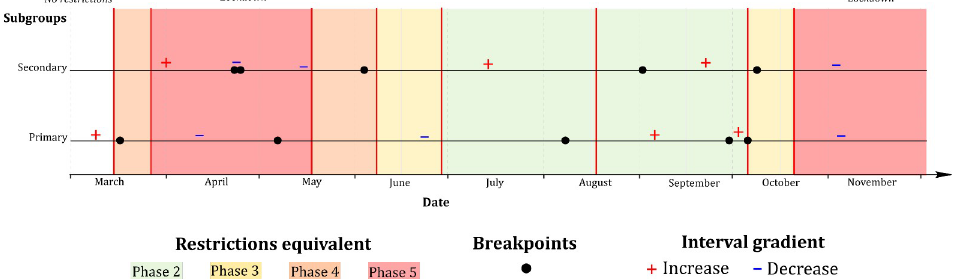
Fig 3. Grid synthesis of primary and secondary time-series breakpoint models (psi = 5) in the Republic of Ireland (cases/day), February 29 th to November 30 th 2020; + and - signs refer to positive and negative interval gradients,